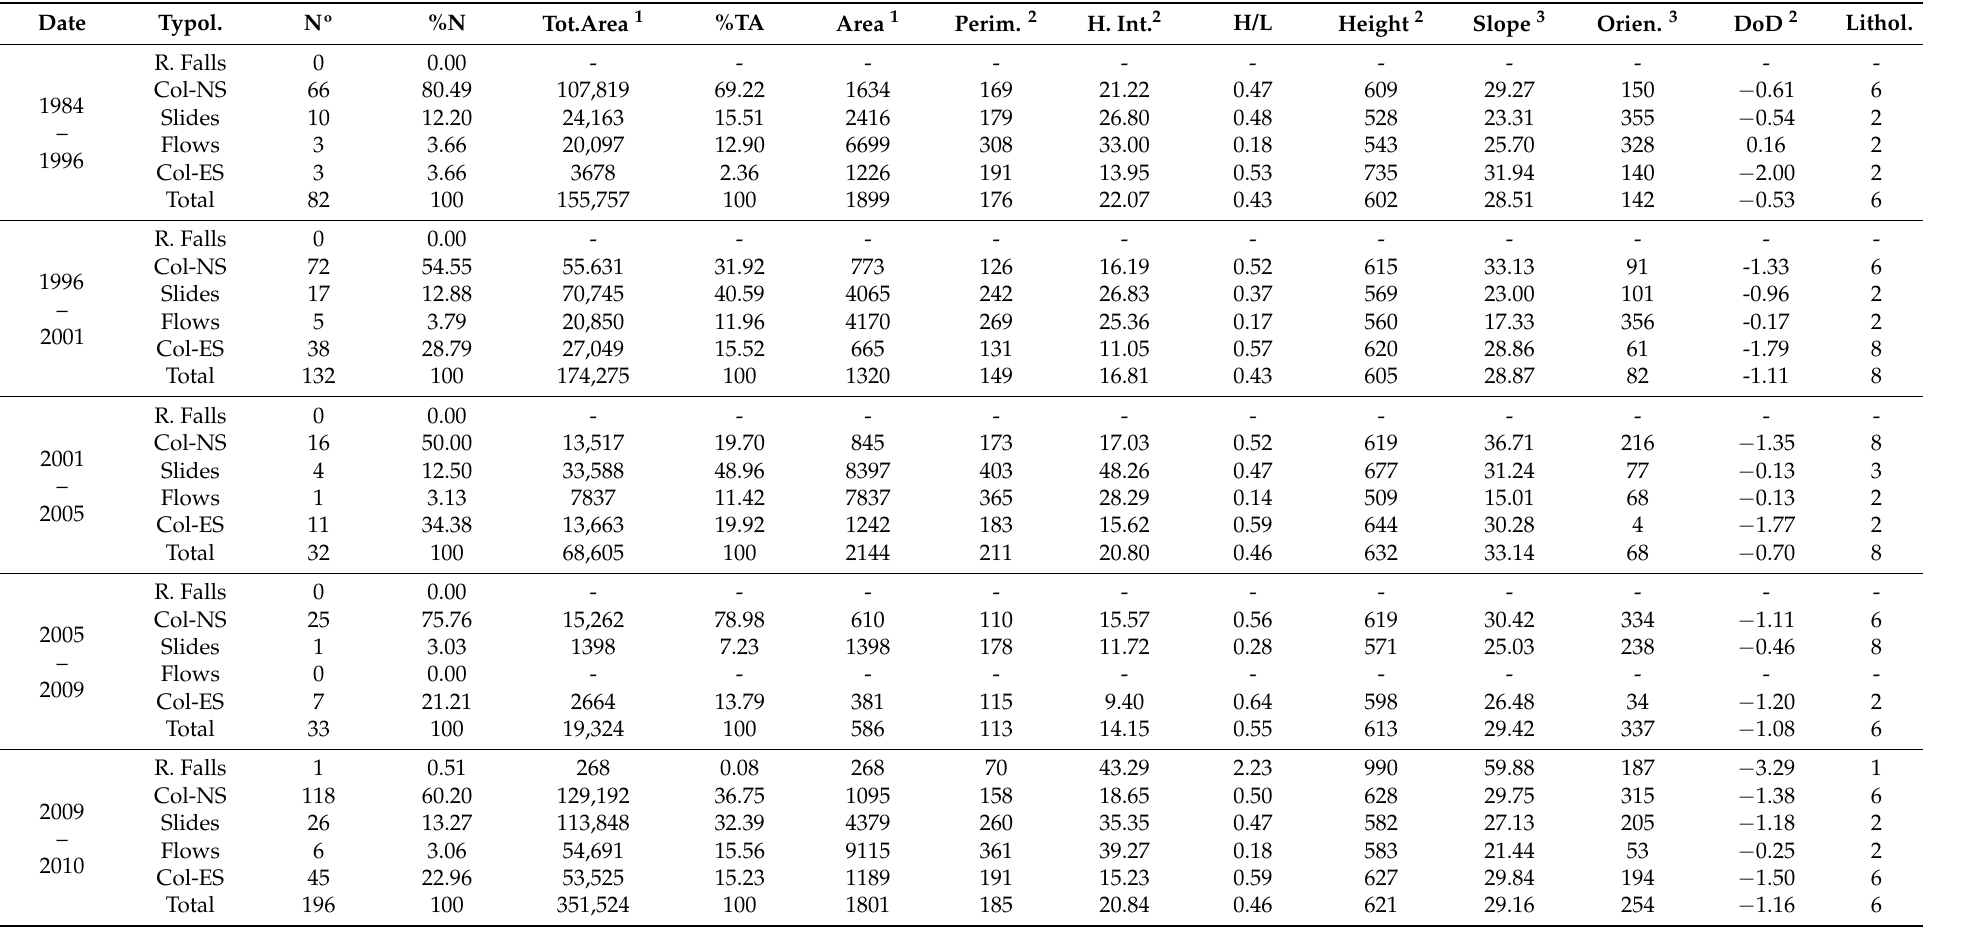
Table 4. Analysis of the multitemporal landslide